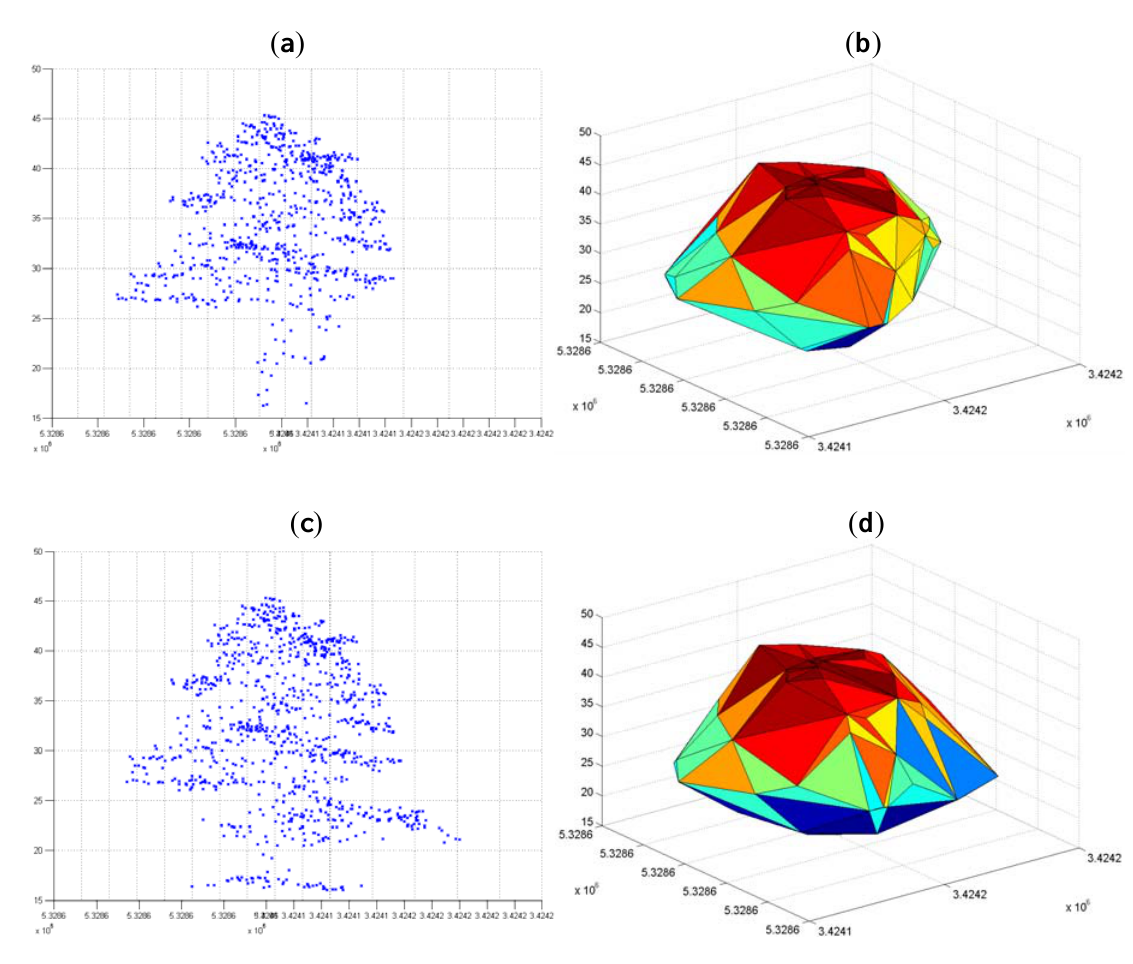
Figure 10. Cluster of an individual tree from Cell 6 after running N k -means on the dataset above 16 m height and respective convex polytope, projected into a freely chosen vertical plane. ( a ) Cell 6—an individual tree cluster by applying N k -means without scaling down the height value. ( b ) 3-D convex polytope reconstructed from an individual tree cluster as shown in ( a ). ( c ) Cell 6—an individual tree cluster by applying N k -means after scaling down the height value. ( d ) 3-D convex polytope reconstructed from an individual tree cluster as shown in (c). The x and y coordinate values (in meters) are displayed horizontally and the z value (in meters) is displayed